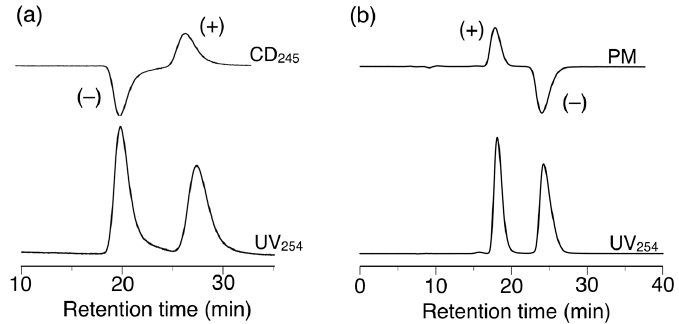
Figure 8. HPLC chromatograms for the resolution of 14 ( a ) and 15 ( b ) on h -poly-( 2 S 0.36 - co - 3 0.64 ). Eluent: hexane–2-propanol (99:1, v / v